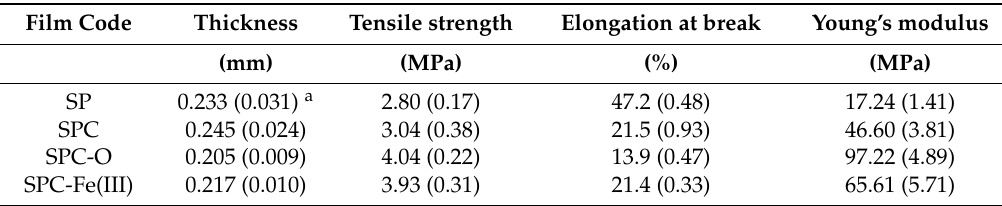
Table 2. Tensile properties (tensile strength (TS), elongation at break (EB), Young’s modulus (YM)) of control and soy-based composite film samples.